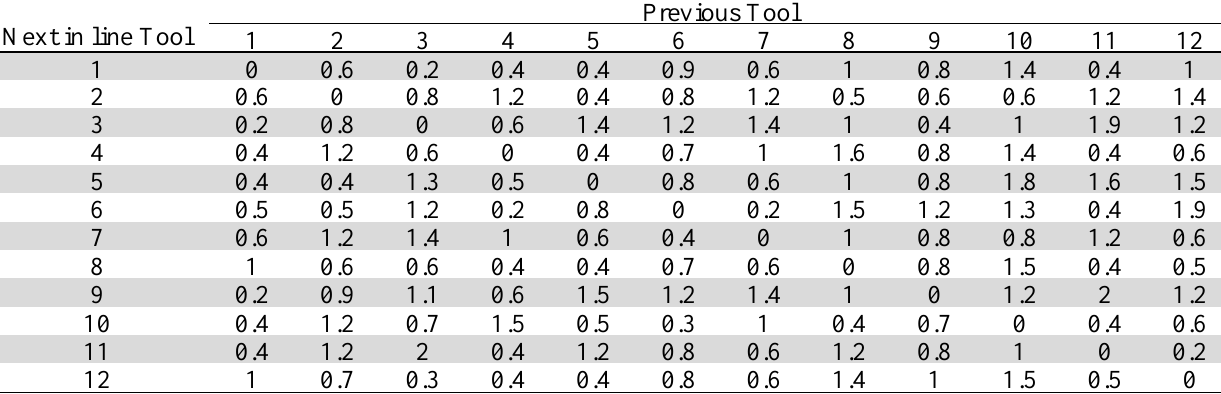
Tool switch times (min) Next in line